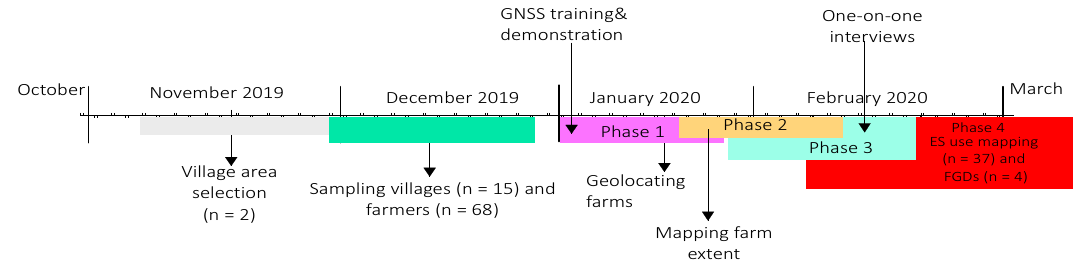
Figure 2. Timeline of research activities undertaken during the study.